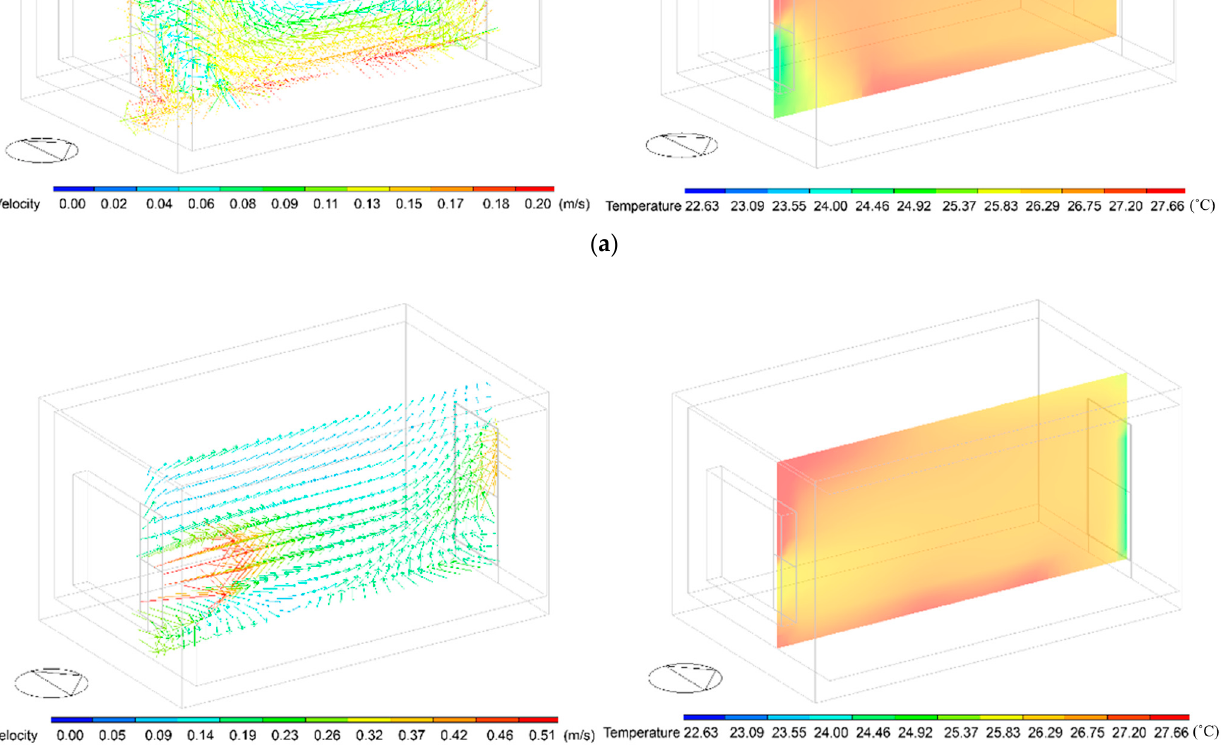
( b ) Figure 18. CFD calculated air velocities and temperatures for the top floor of the naturally ventilated building: ( a ) internal doors are closed and ( b ) doors are opened (cross-ventilation) (27 October, 16:00).